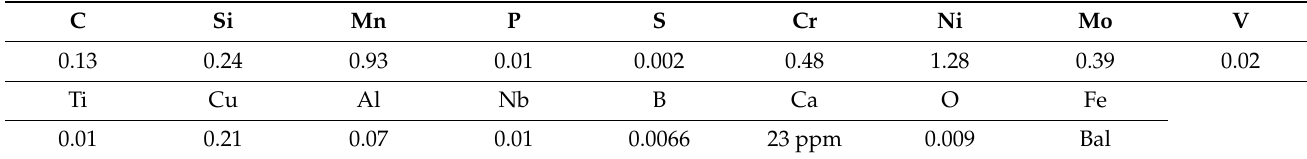
Table 1. BIS 812 EMA Steel composition (wt%) [14].